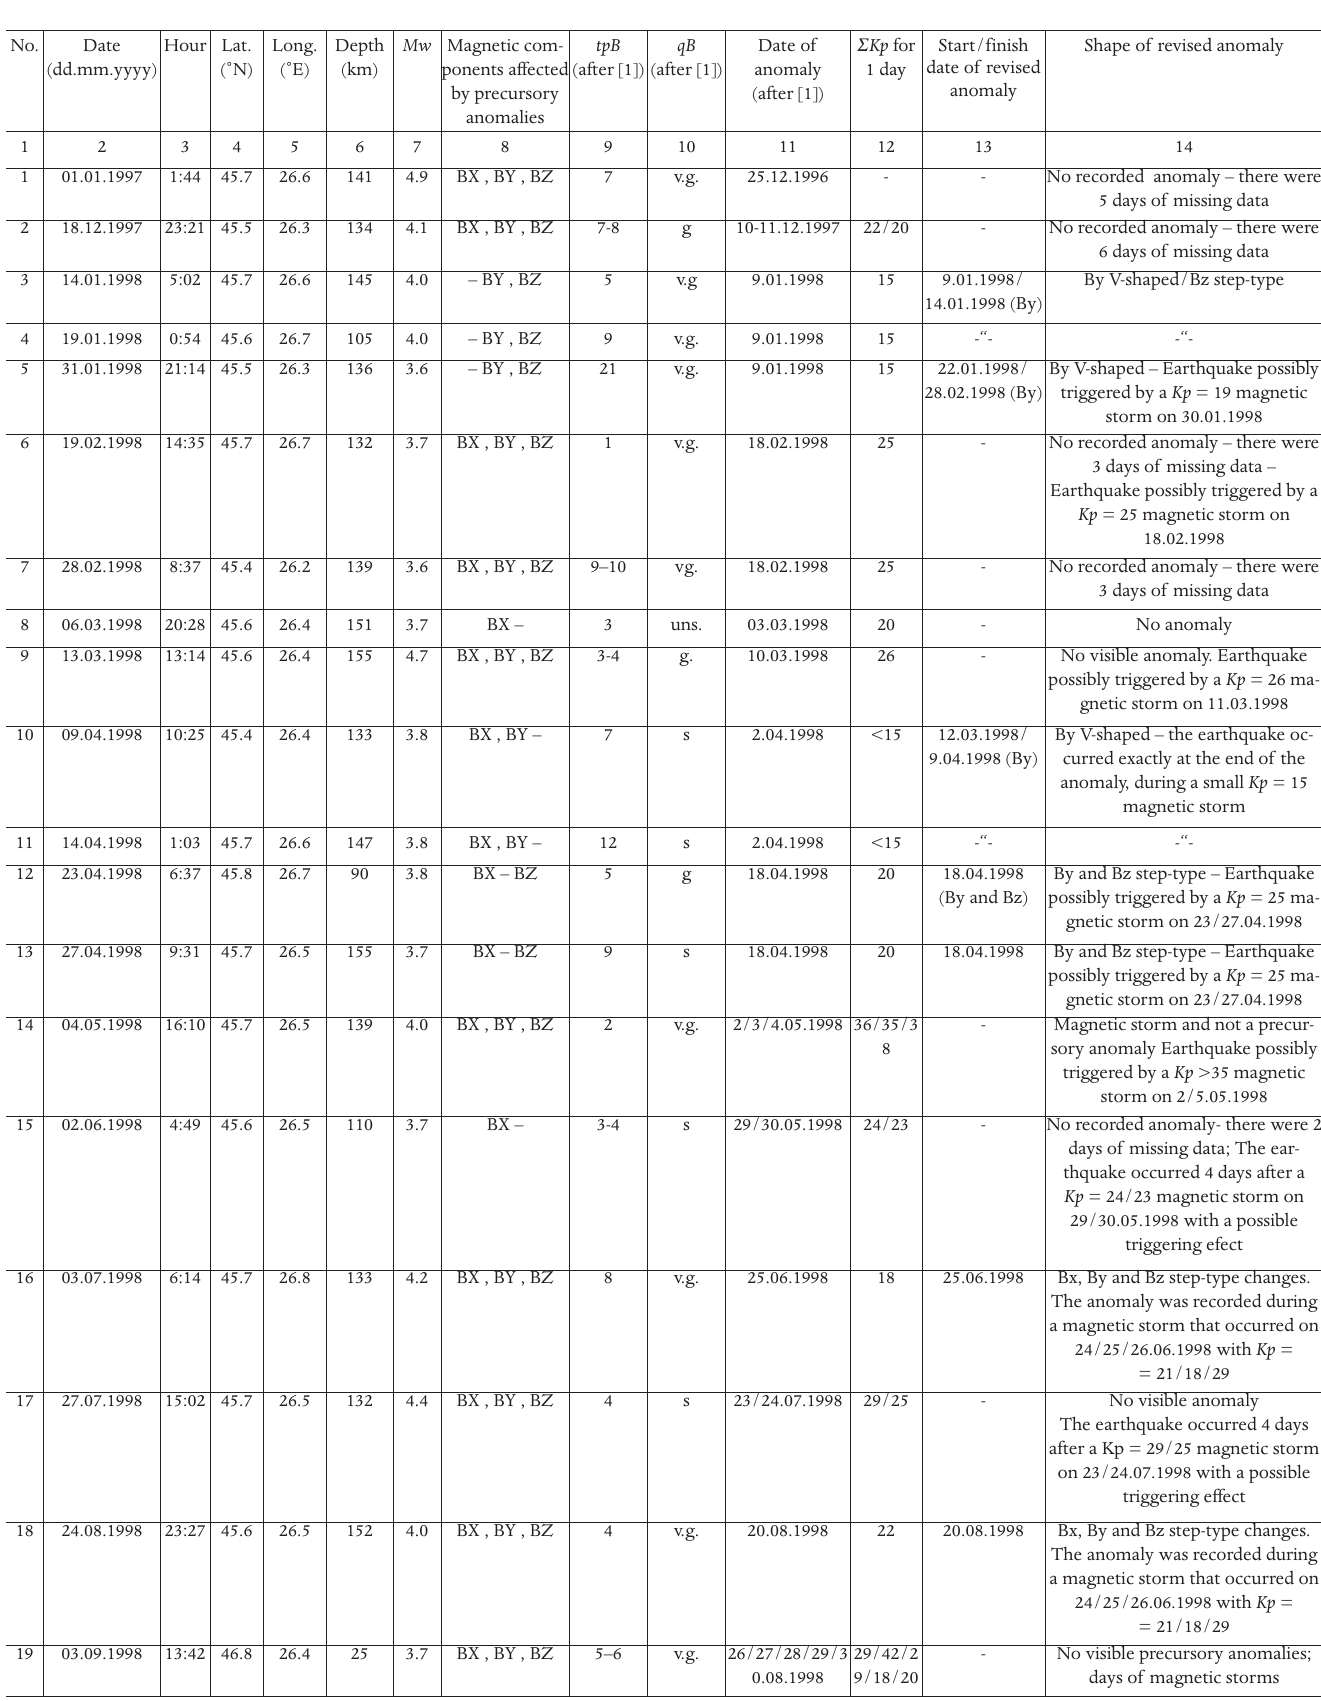
Table 2. Seismological parameters and electromagnetic precursory data of all of the Vrancea earthquakes of magnitudes Mw ≥ 3.5 that occurred in the period investigated by Enescu et al.